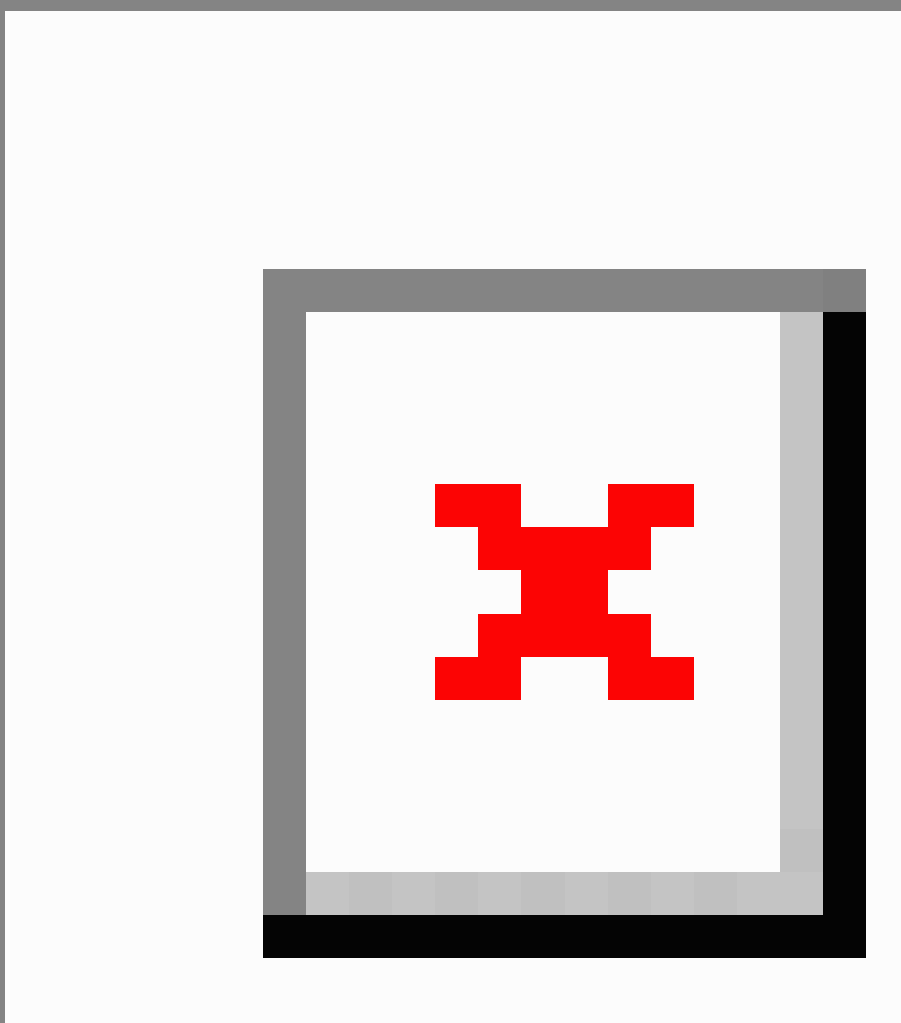
Figure 1. Adderall-related tweets by day of the